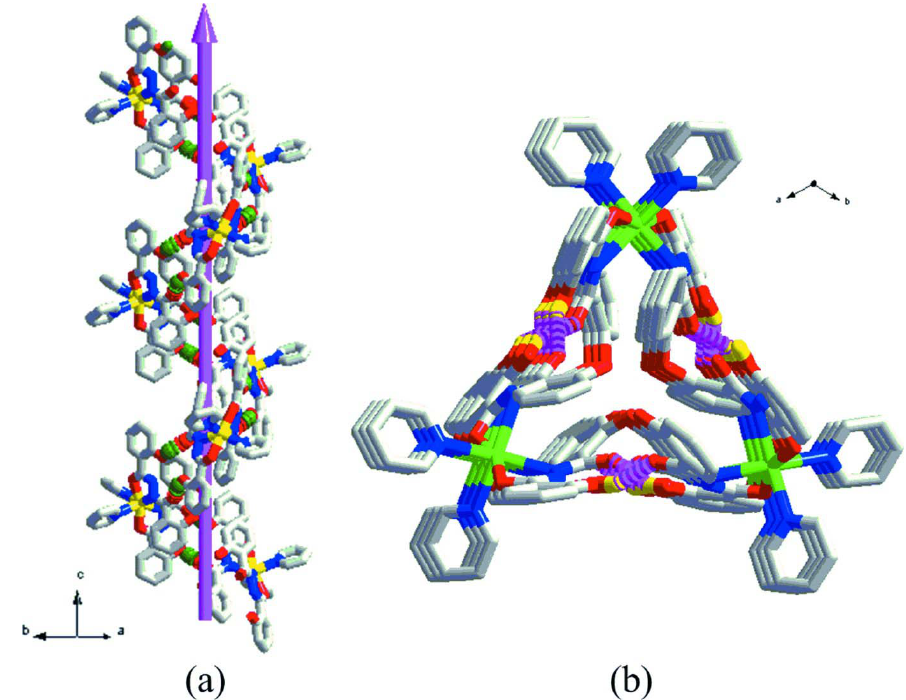
Figure 2 Supramolecular structure of the title complex in the direction